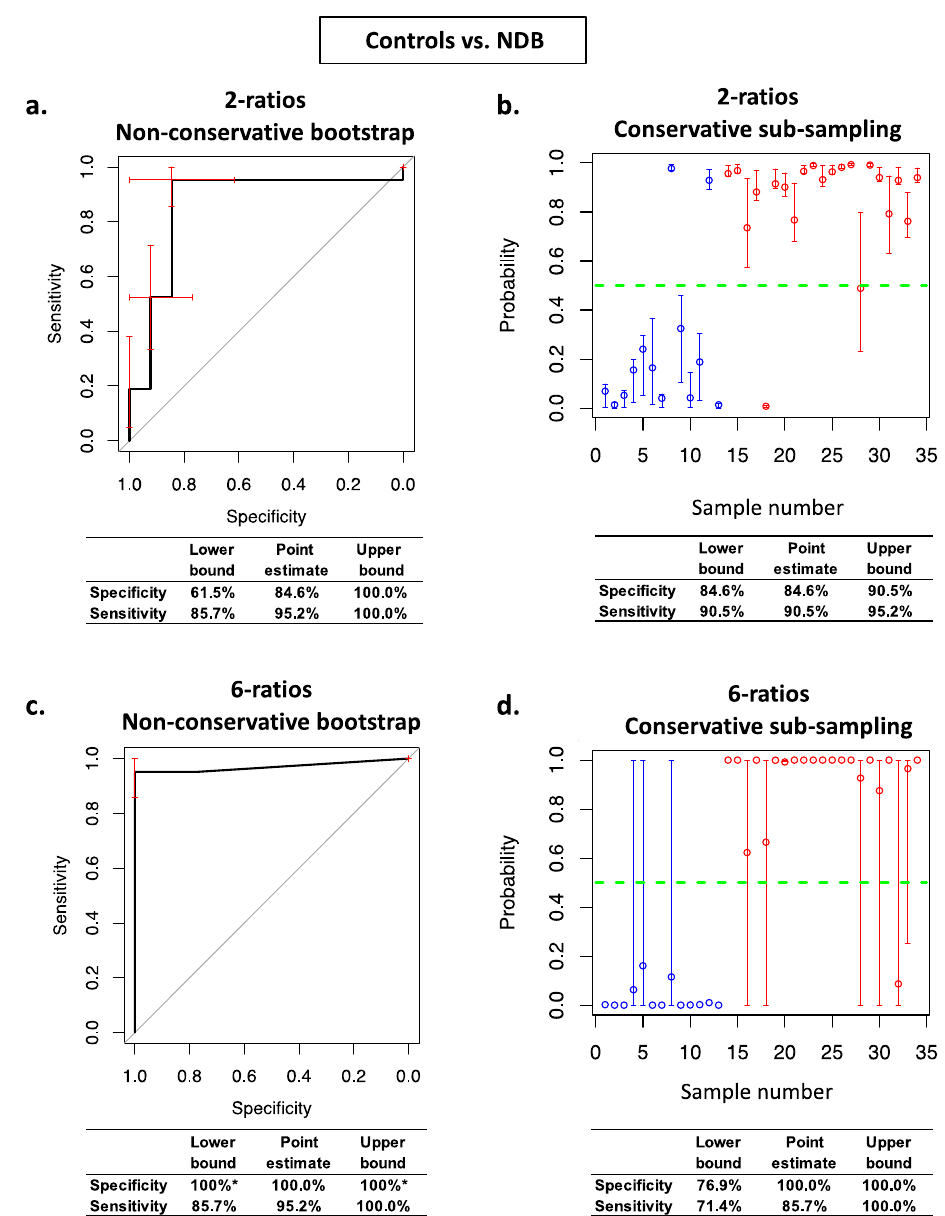
relative to the standard nested cross validations for both Controls vs. NDB (97.6% vs. 64.1% accuracy; Figure 2c vs. Figure 1a;) and for NDB vs. HGD (97.6% vs. 56.9% accuracy; Figure 3c vs. Figure 1c).